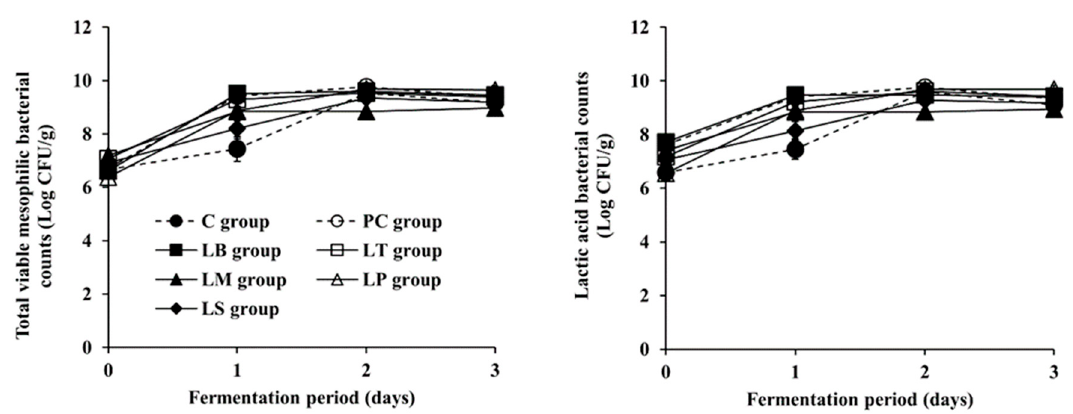
Figure 2. Changes in microbial properties of Baechu kimchi during fermentation. ● : C group without an inoculum (control), ○ : PC group inoculated with tyramine-producing L. brevis isolated from kimchi product (positive control), ■ : LB group inoculated with BA-degrading L. brevis PK08, □ : LT group inoculated with BA-degrading L. pentosus PK05, ▲ : LM group inoculated with BA-degrading Leu. mesenteroides YM20, △ : LP group inoculated with BA-degrading L. plantarum KD15, ◆ : LS group inoculated with BA-degrading L. sakei YM21.